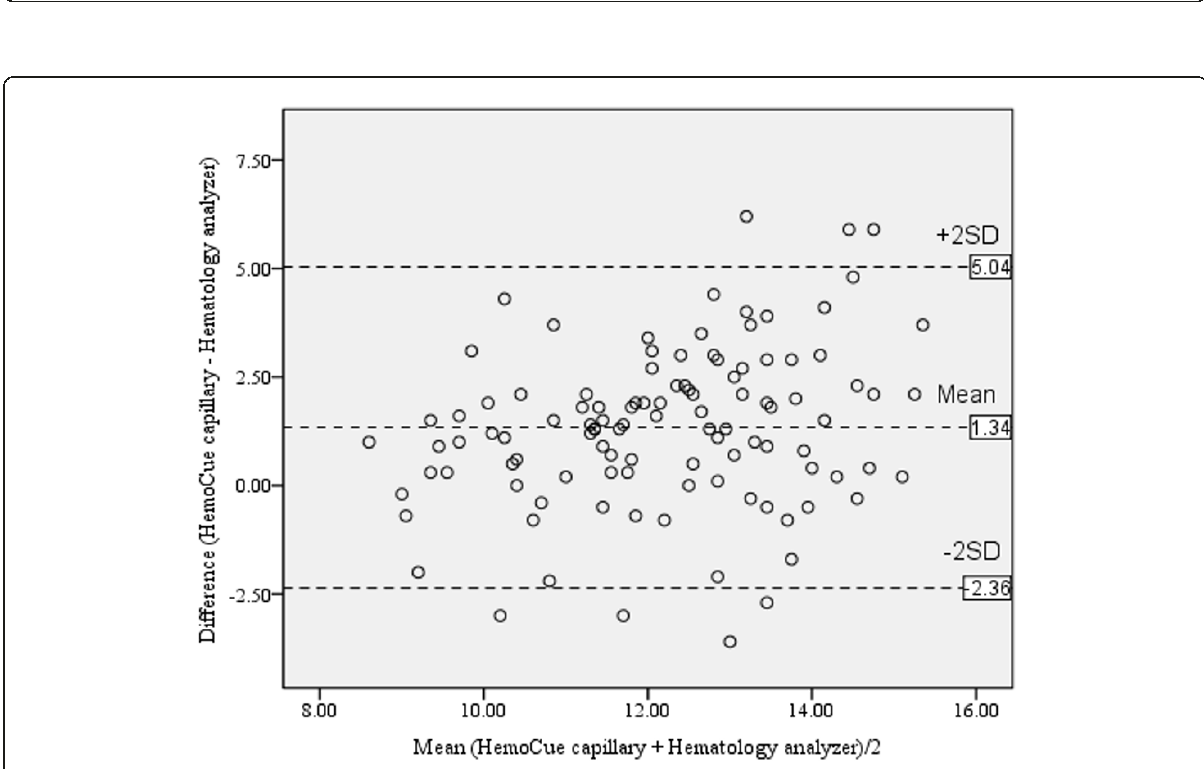
Figure 1 Bland and Altman plot for hemoglobin level by using HemoCue ® venous sample versus automated hematology analyzer (g/dl) .